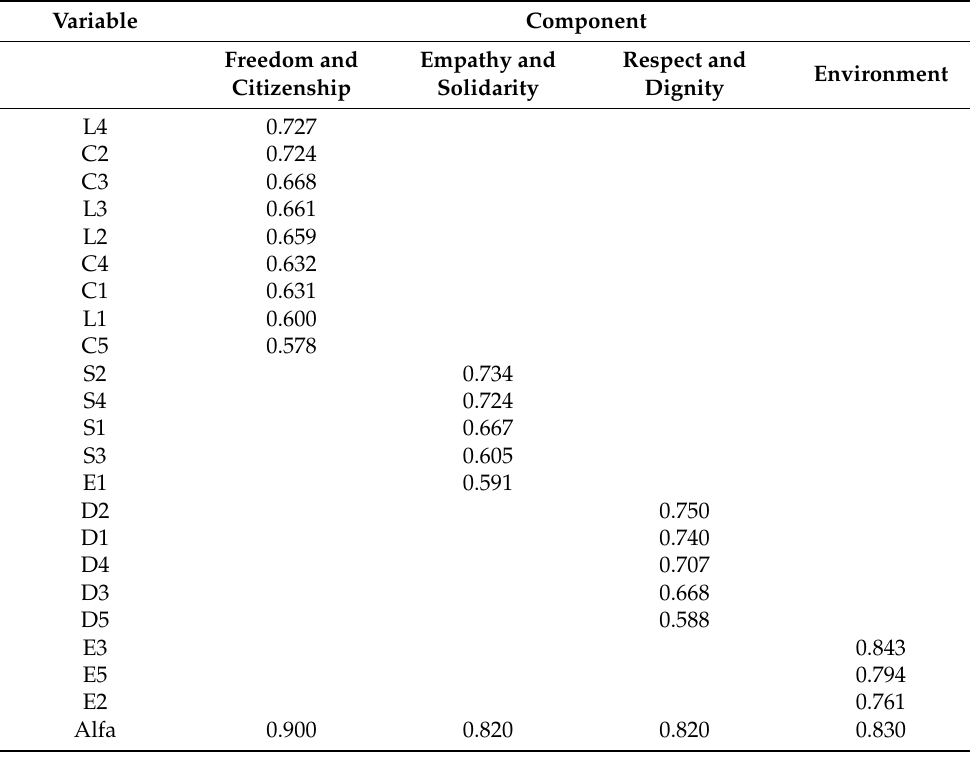
Table 3. Matrix of rotated social responsibility components in HEIs from the SDG (Sustainable Development Goals)